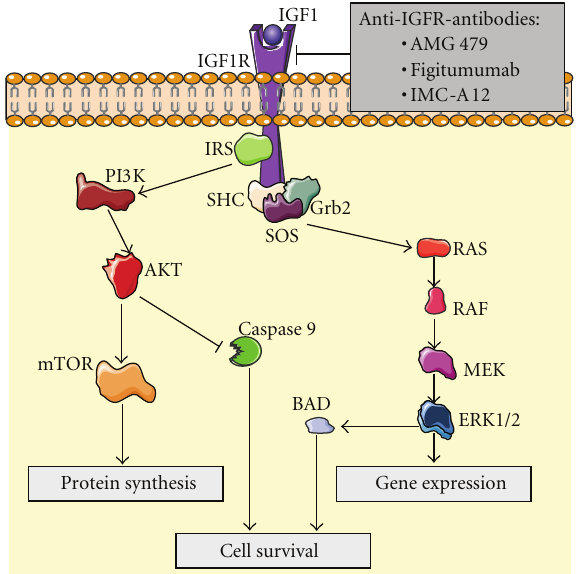
Figure 2: The activation of IGFR by ligand binding triggers a signal transduction pathway that causes the activation of mTOR pathway and inhibition of apoptosis, thus promoting cell survival. Anti-IGFR antibodies prevent this e ff ect.